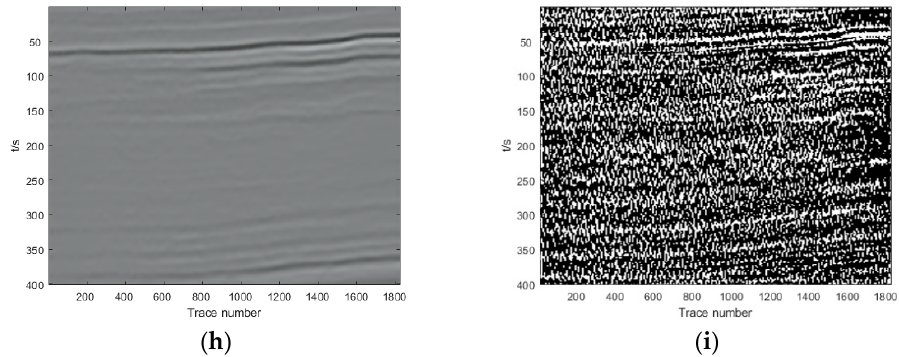
Figure 14. Denoising results of the fifth field example. ( a ) Noisy data; ( b ) Denoised image through the pre-trained model; ( c ) The difference profiles between noisy data ( a ) and pre-denoised data ( b ); ( d ) Denoised data through the proposed method; ( e ) The difference profiles between noisy data ( a ) and denoised data ( d ); ( f ) Denoised data through the DnCNN; ( g ) The difference profiles between noisy data ( a ) and denoised data ( f ); ( h ) Denoised data through the U-net; ( i ) The difference profiles between noisy data ( a ) and denoised data ( h ).